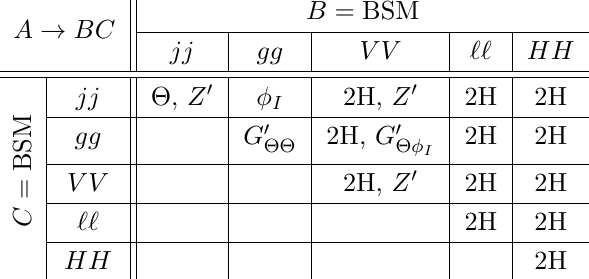
Table 5 . Example (Group V in table 1) for A ! BC , where A , B and C are BSM particles. Each of B and C decays to similar kinds of SM particles. The jj denotes a diquark with all possible (cid:13)avor combinations. Here the V V includes (cid:13)(cid:13) , (cid:13)Z , ZZ , ZW , (cid:13)W , or WW . We abbreviate the decays G 0 (cid:17) G 0 ! (cid:2) (cid:30) I , G 0 (cid:17) G 0 ! (cid:2)(cid:2), (cid:2) (cid:17) (cid:2) ! G 0 G 0 , and (cid:30) I (cid:17) (cid:30) I ! (cid:2) G 0 where G 0 , (cid:2)(cid:2) (cid:2) (cid:30) I (cid:2), and (cid:30) I denote a coloron, color-octet scalar, and a singlet scalar respectively [33, 34]. Extended Two-Higgs Doublet Model with a real singlet (2HDMS) [35, 36] allow for the decay of a CP-even heavy scalar into light scalars, abbreviated as 2 H (cid:17) H 00 ! H 0 H 0 . We also consider heavy Z boson decays Z 0 (cid:17) Z 0 ! W 0 + W 0(cid:0) ; H + H (cid:0) ; W 0(cid:6) H (cid:7) ; or H ++ H (cid:0)(cid:0) where H (cid:6) and H (cid:6)(cid:6) are singly- and doubly-charged scalars.